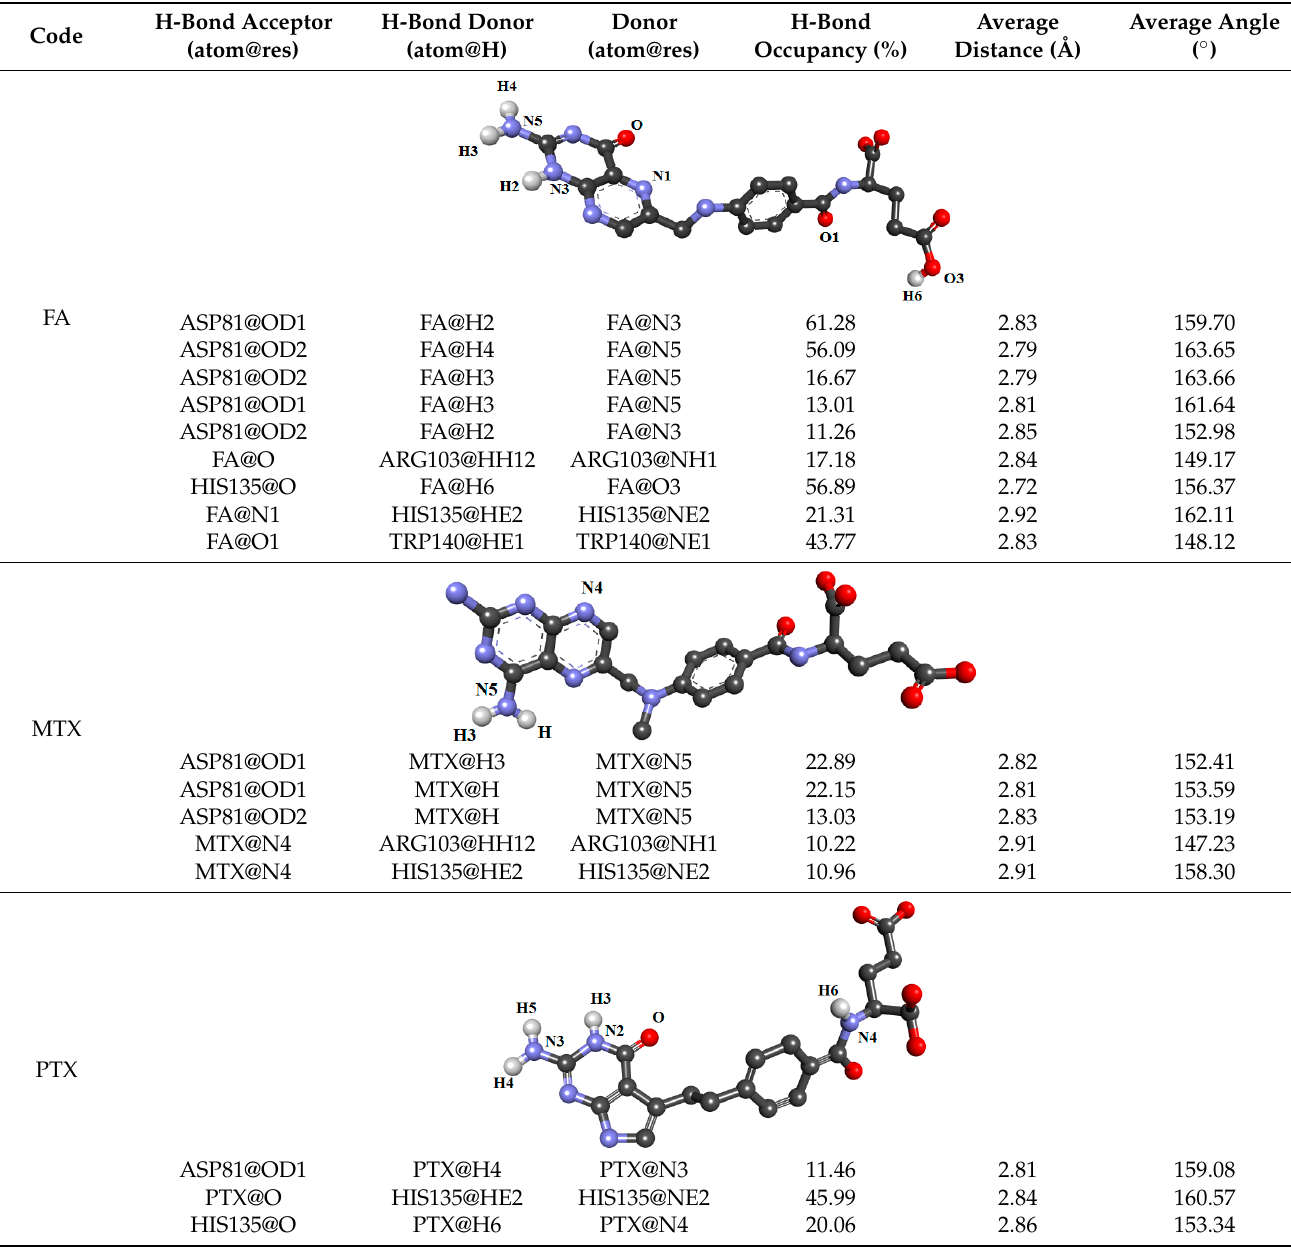
Table 3. Hydrogen bond analysis for 100 ns of MD simulation for FA, MTX, PTX, FOL03, and FOL08 within the FR α active site.